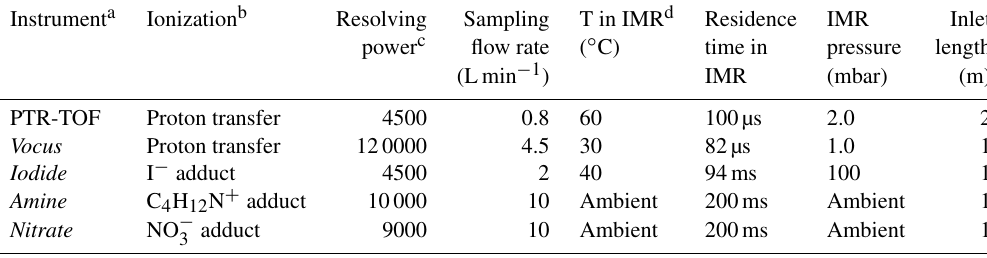
Table 1. Overview and characteristics of the mass spectrometers deployed during the campaign at the COALA chamber. Instrument a Ionization b Resolving Sampling